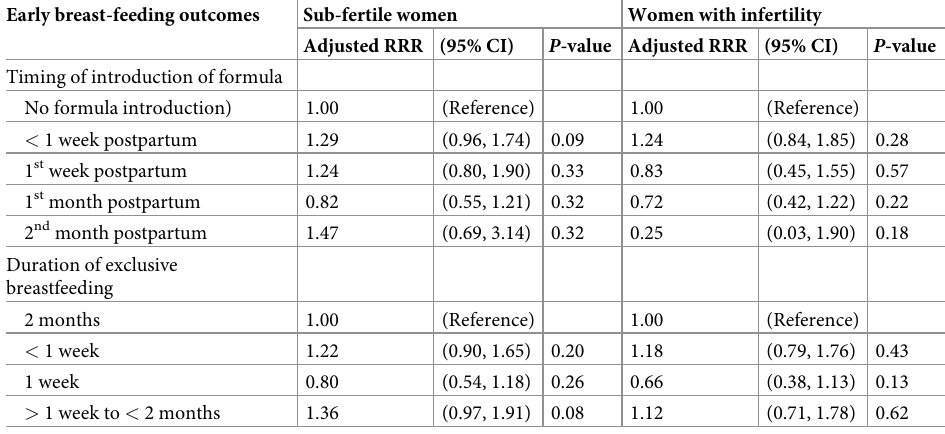
Table 4. Association between mode of conception and early breastfeeding outcomes in women with singleton ges- tations (N = 3,536). Early breast-feeding